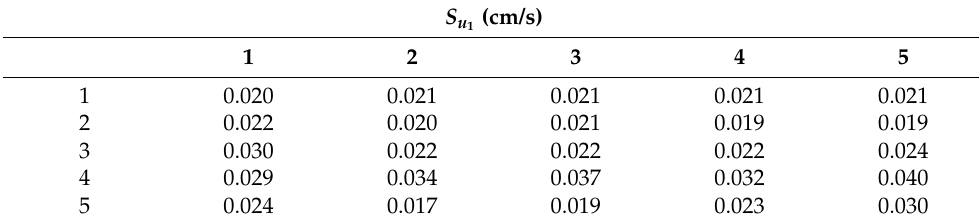
Table 5. Mean square errors of the measured u at the inflow